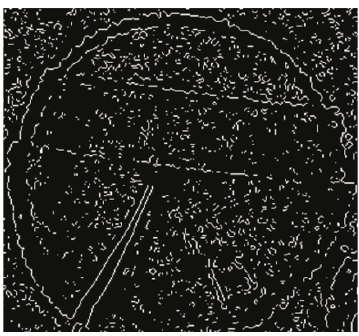
Figure 8: Image after edge detection using Roberts operator.